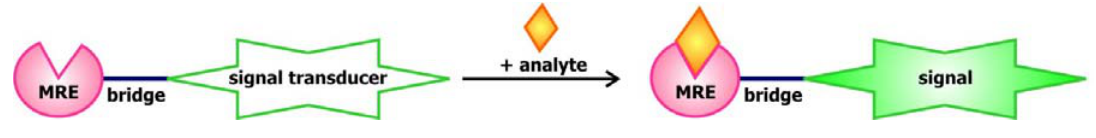
Figure 3. Anatomy of biosensors.